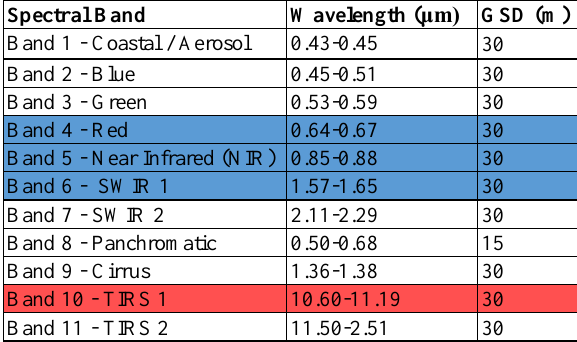
Table 6. Landsat 8 spectral band characteristics (USGS, 2020).